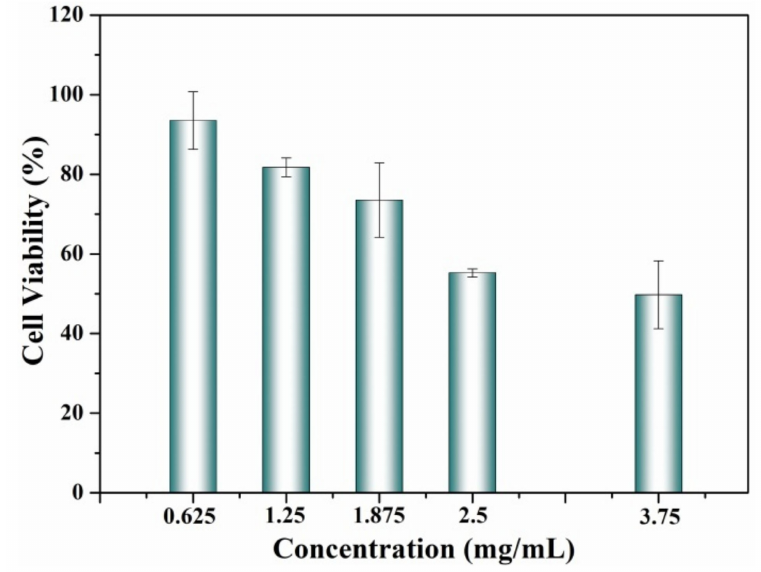
Figure 8. Cytotoxicity of MAG/C–ZnO/APT-2.5% nanocomposite on